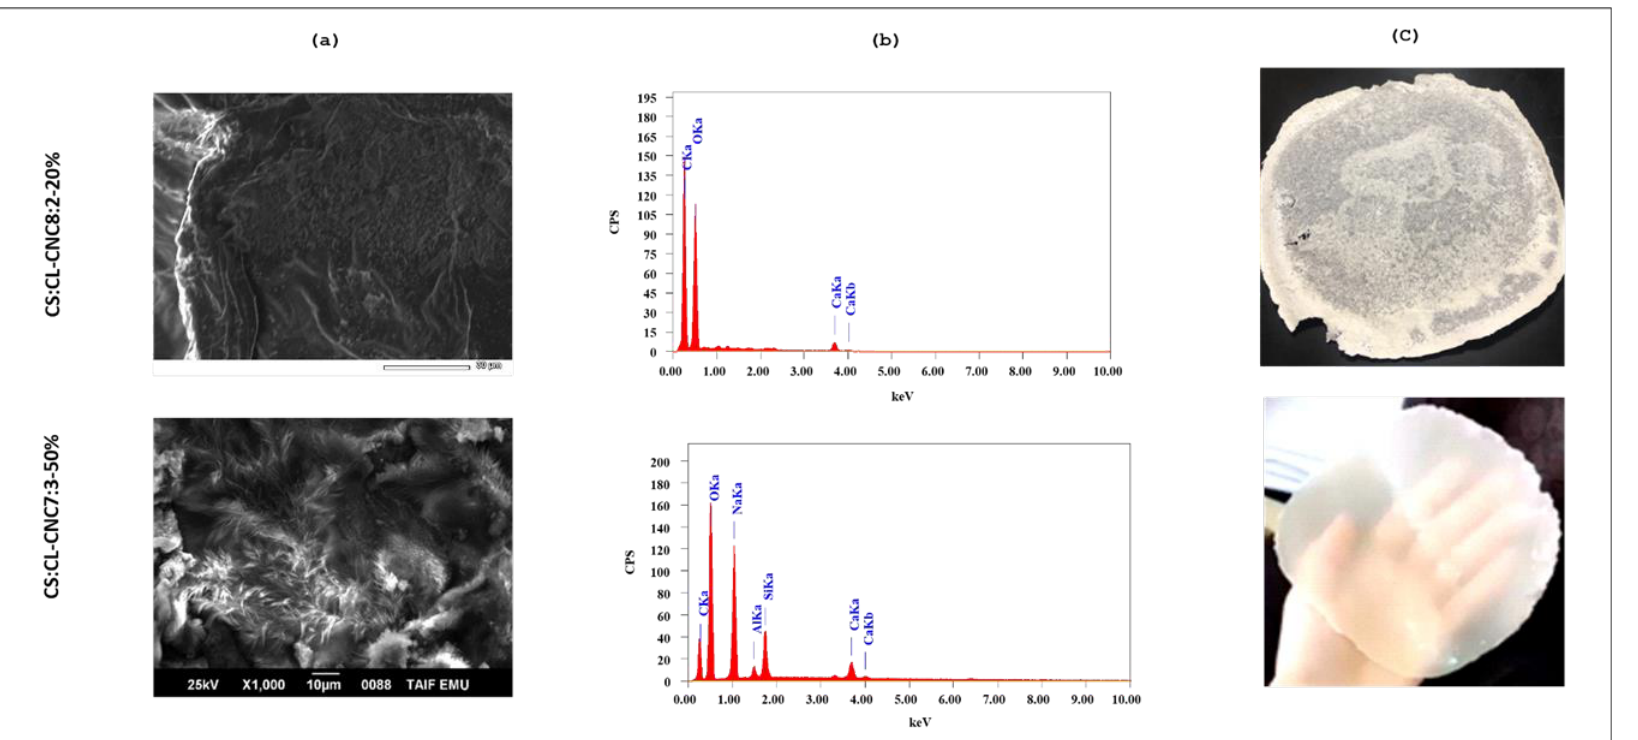
Figure 3. ( a ) SEM, ( b ) EDX, and ( c ) real photo of bio-composites films CS: CL-CNC 8:2-20% (brittle and broken film) and CS:CL-CNC7:3-50% (compact and flexible, see Supplementary Video S1) with magnification 1000×.